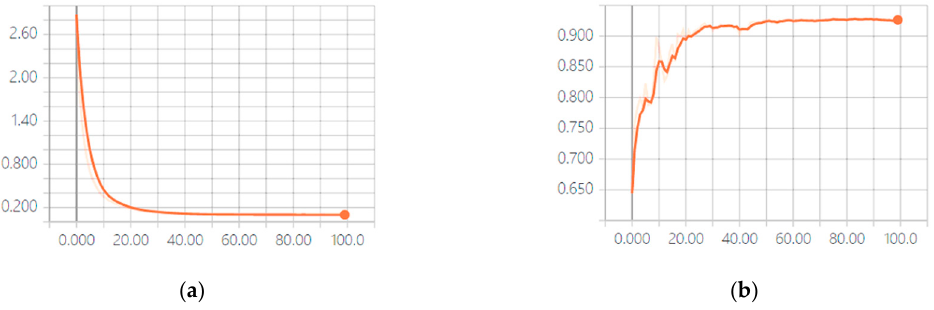
Figure 8. Training and test curve on NTU dataset (cross-view): ( a ) training loss curve; ( b ) test accuracy curve.